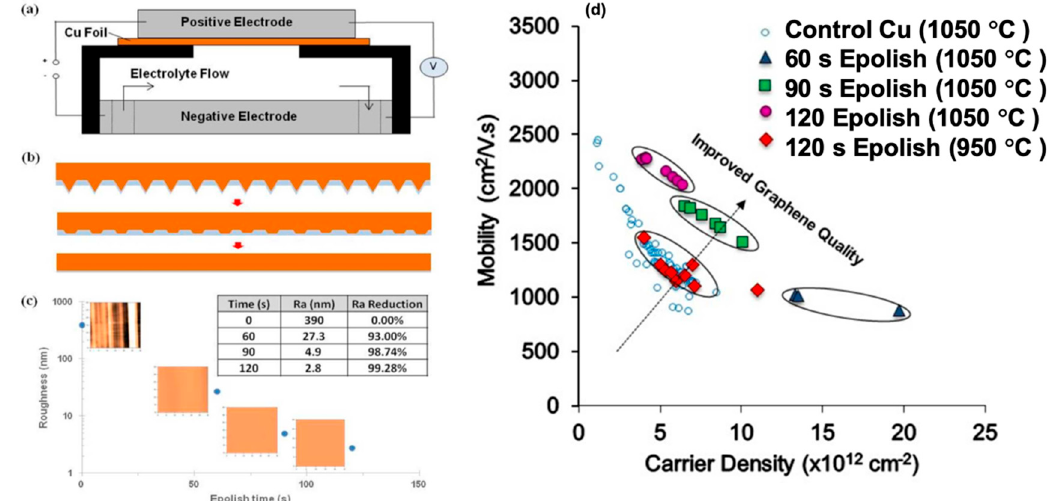
Figure 15. Schematic of ( a ) EP setup and ( b ) planarization mechanism during polishing. ( c ) AFM images showing as received Cu compared to EP Cu using different EP times. The inset table displays the measured surface roughness of the EP samples over time and the reduction rate from the as-received sample (reprinted with permission from [130]); ( d ) a plot of mobility versus carrier density of CVD grown graphene on EP Cu (reprinted with permission from [131]).